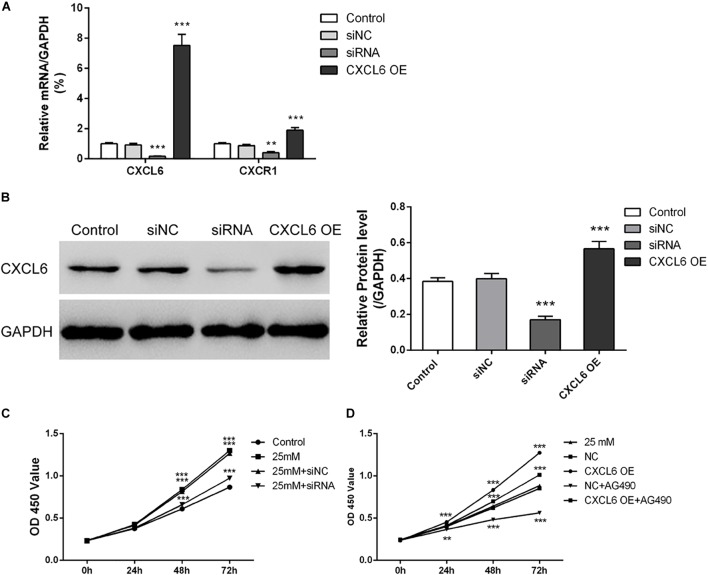
Effect of CXCL6 on the proliferation of high glucose-induced NRK-49F. The efficiency of CXCL6 shRNA viral or overexpression lentivirus in silencing or over-expressing CXCL6 in NRK-49F cells was determined by qRT-PCR (A) and WB (B). Following this, cck8 assays were performed to evaluate high glucose-induced NRK-49F cell viability when CXCL6 was either knocked down (C) or over-expressed (D). ∗∗P < 0.01, ∗∗∗P < 0.001.